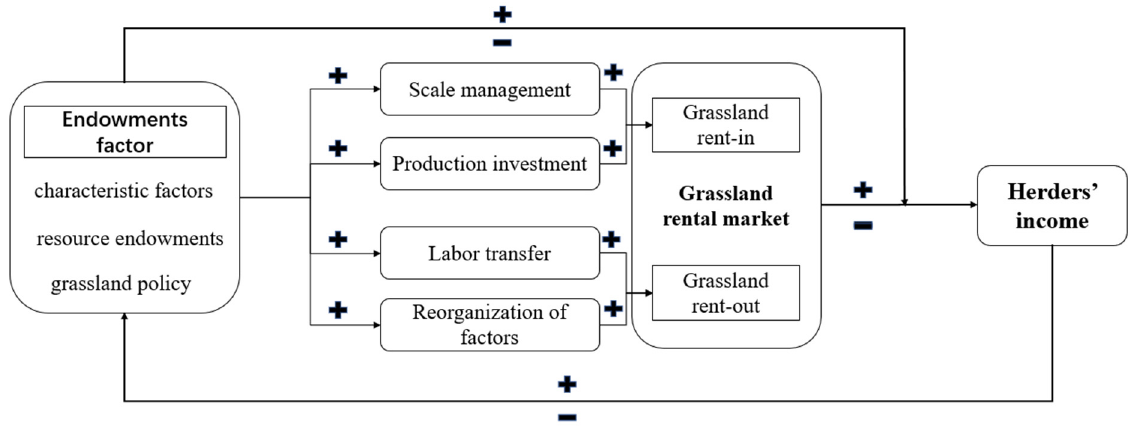
Figure 1. A theoretical framework of this study (The symbols indicate the expected impacts).